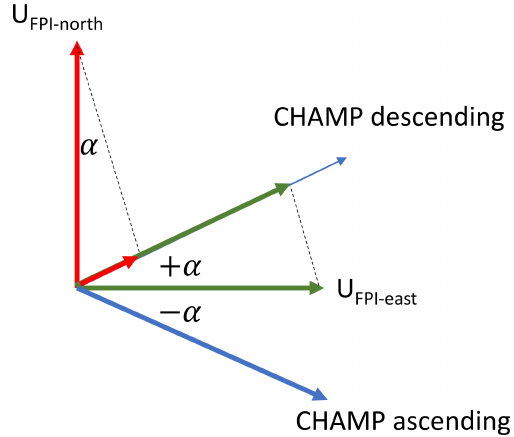
Figure 3. Geometry illustrating the projection of the FPI viewing direction horizontal wind components onto the CHAMP cross-track orientation for the ascending and descending